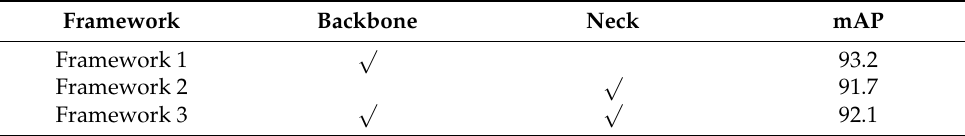
Table 4. C3CA ablation